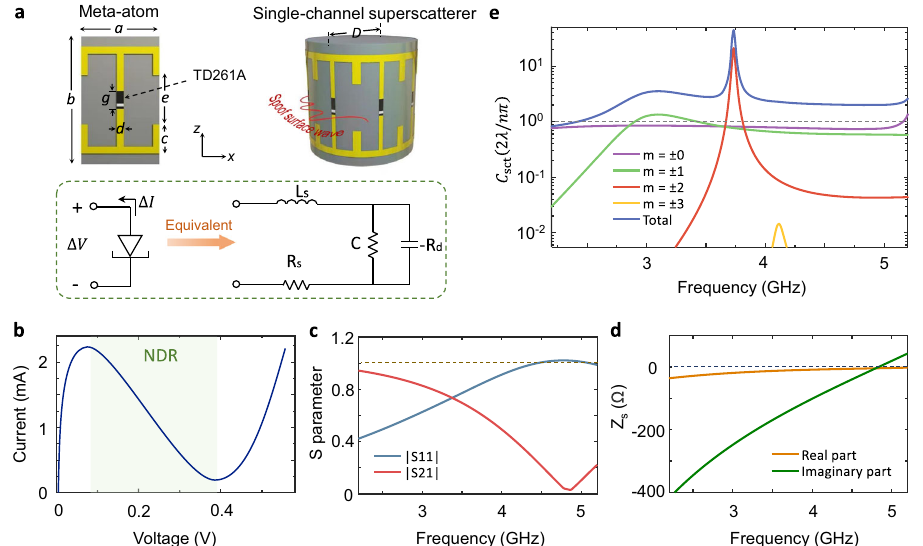
Fig. 3 | Experimental design of the gain metasurfaces and the single-channel superscatterer in the microwave regime. a Schematic of the designed single- channelsuperscattererandtheequivalentcircuitmodelofdeployedTD261Acells. Thesingle-channelsuperscatterercomprisesasubwavelengthTe fl onrodencircled by a fl exible layer of gain metasurfaces, which contains eight meta-atoms. Inside each meta-atom, a tunnel diode (TD261A) is welded to provide a negative differ- ential resistance(NDR,namely, gain); see its equivalent circuit model in the fi gure. Thedimensionsofeachmeta-atomare a =11, b =18, e =7, c =4, d =1,and D =28,all